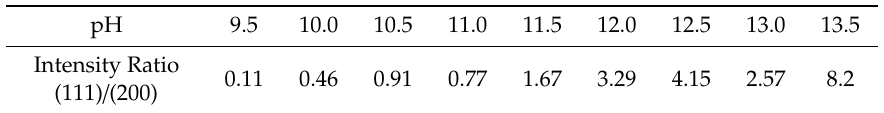
Table 2. Relative intensities of observed di ff raction peaks variation with the di ff erent bath pH levels of the p -Cu 2 O